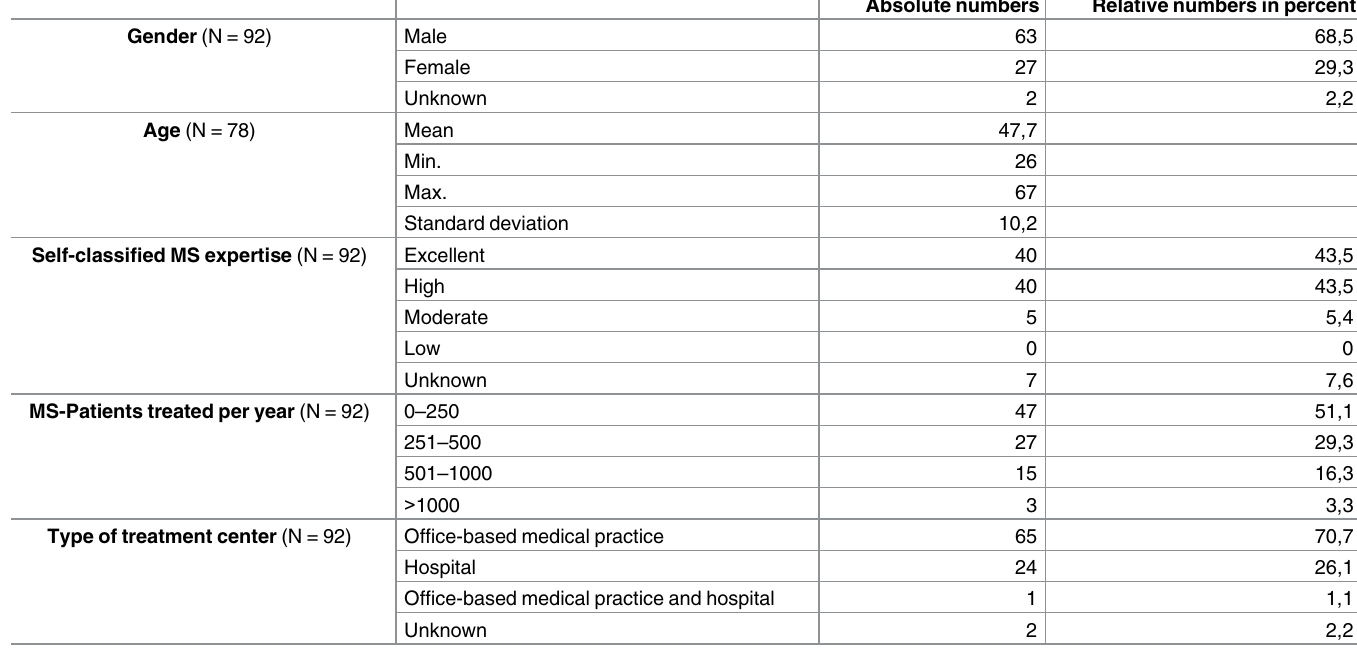
Table 1. Descriptivedemographic and professional details of participating neurologists at baseline. N describesthe number of neurologists with fully completedquestionnaires at